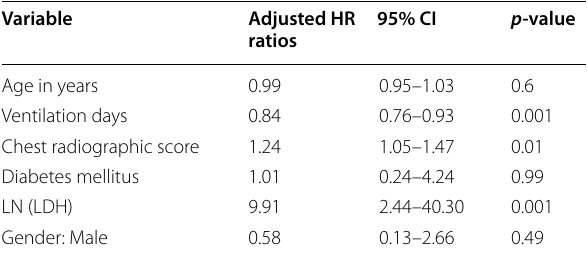
Table 3 Multivariate cox regression analysis to see association of mortality in 57 MERS-Cov